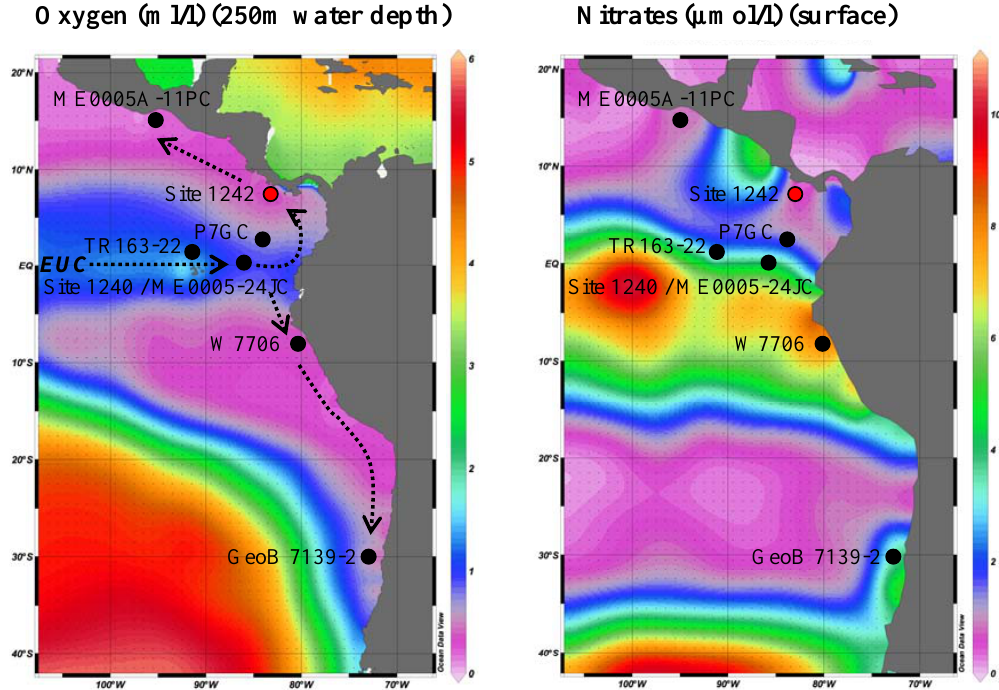
Fig. 1. Sub-surface dissolved oxygen concentrations at 250m water depth and surface nitrate concentrations (Garcia et al., 2006). Locations of ODP Site 1242 (this study) as well as additional sites (TR163-22, ODP Site 1240, ME0005-24JC, P7GC, W7706, GeoB 7139-2) discussed in the text are marked with a black dot. Sub-surface current EUC (Equatorial Undercurrent) is also indicated by an